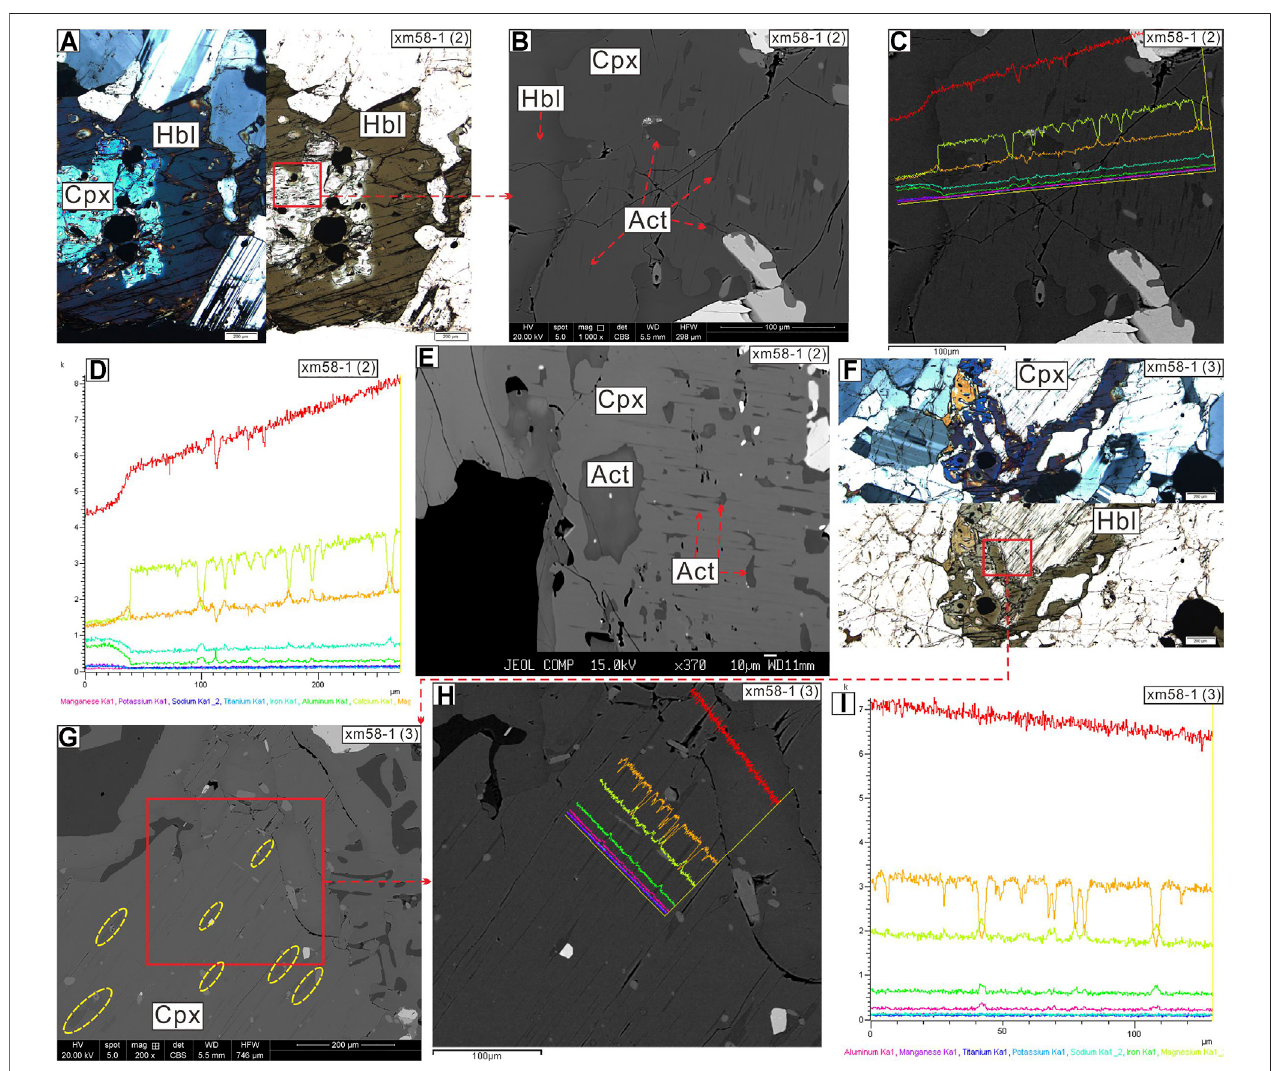
FIGURE10| Photomicrographsoftheclinopyroxene-amphibole(Cpx-Amp)texturesand compositionalscans. (A,F) PhotomicrographofCpx-Ampundercross- polarized light and plane-polarized light. (B, E, G) BSE image of the close-up area from the Cpx. (C, D, H, I) Compositional scan of the Cpx along a line. Abbreviations: Act-actinolite; Amp-amphibole; Cpx-clinopyroxene.